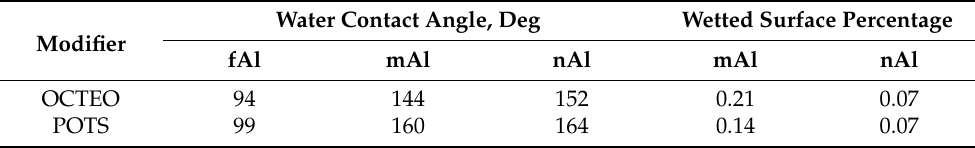
Table 2. Wetting parameters of the studied surfaces with water.